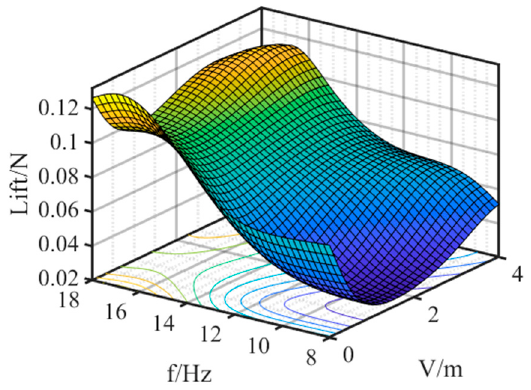
Figure 10. Response surface of wind speed and frequency of RBF.